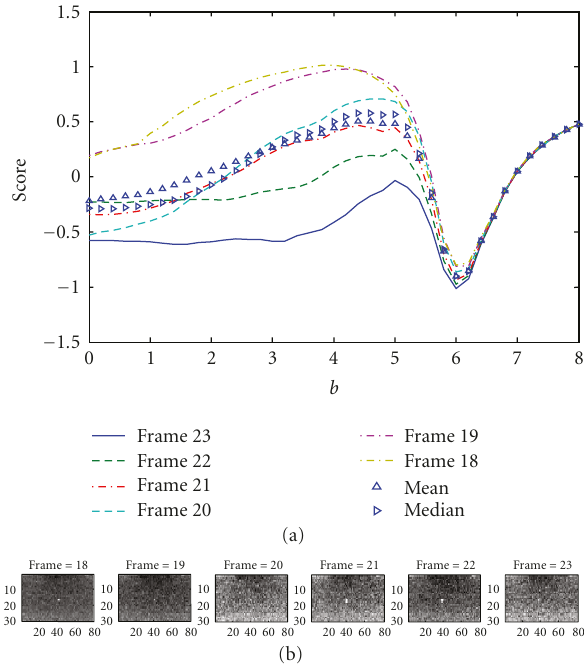
Figure 13: NA23A sequence, s n = 4. (a) The A S for g = 0, Max Numbers = 5, b = [0 ··· 8], and the six last frames, (b) images of the six last frames after the DPA